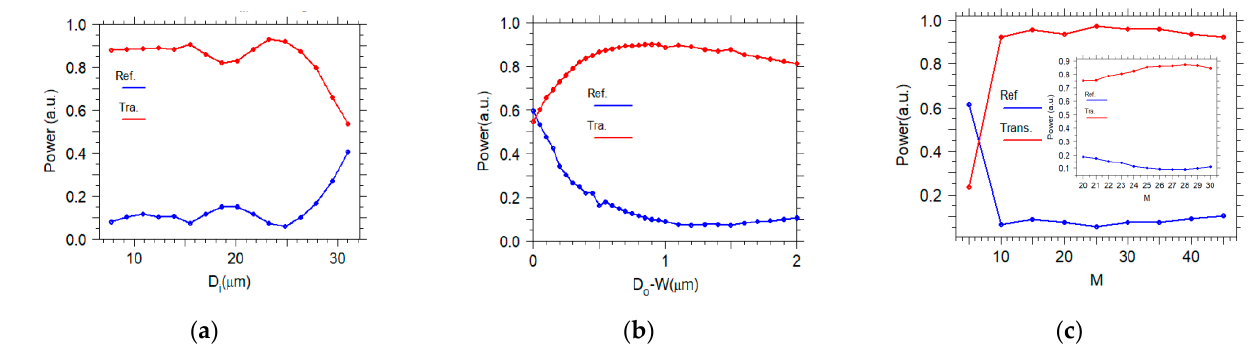
Figure 7. Transmission and reflection change as a function of ( a ) input width, ( b ) output width, ( c ) taper length, for a convex taper at 𝜆 = 4.26 µm, respectively.